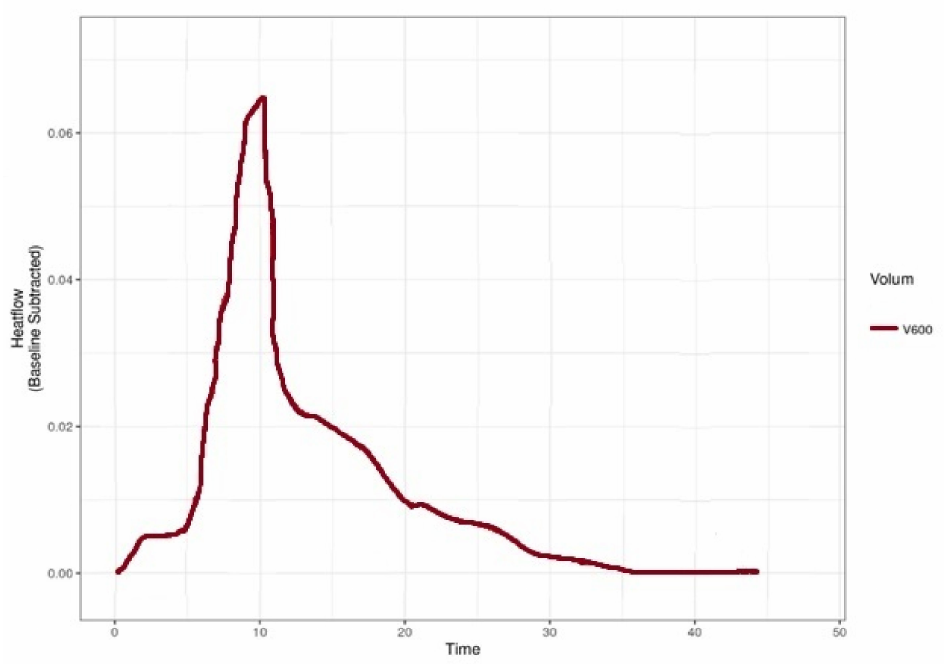
Figure 5. Graphical representation of the growth curve generated by the heat released by the active metabolism of S. Aureus—P2 . Experiments performed at 37 ◦ C and with a microcalorimetric cell load of 600 µ